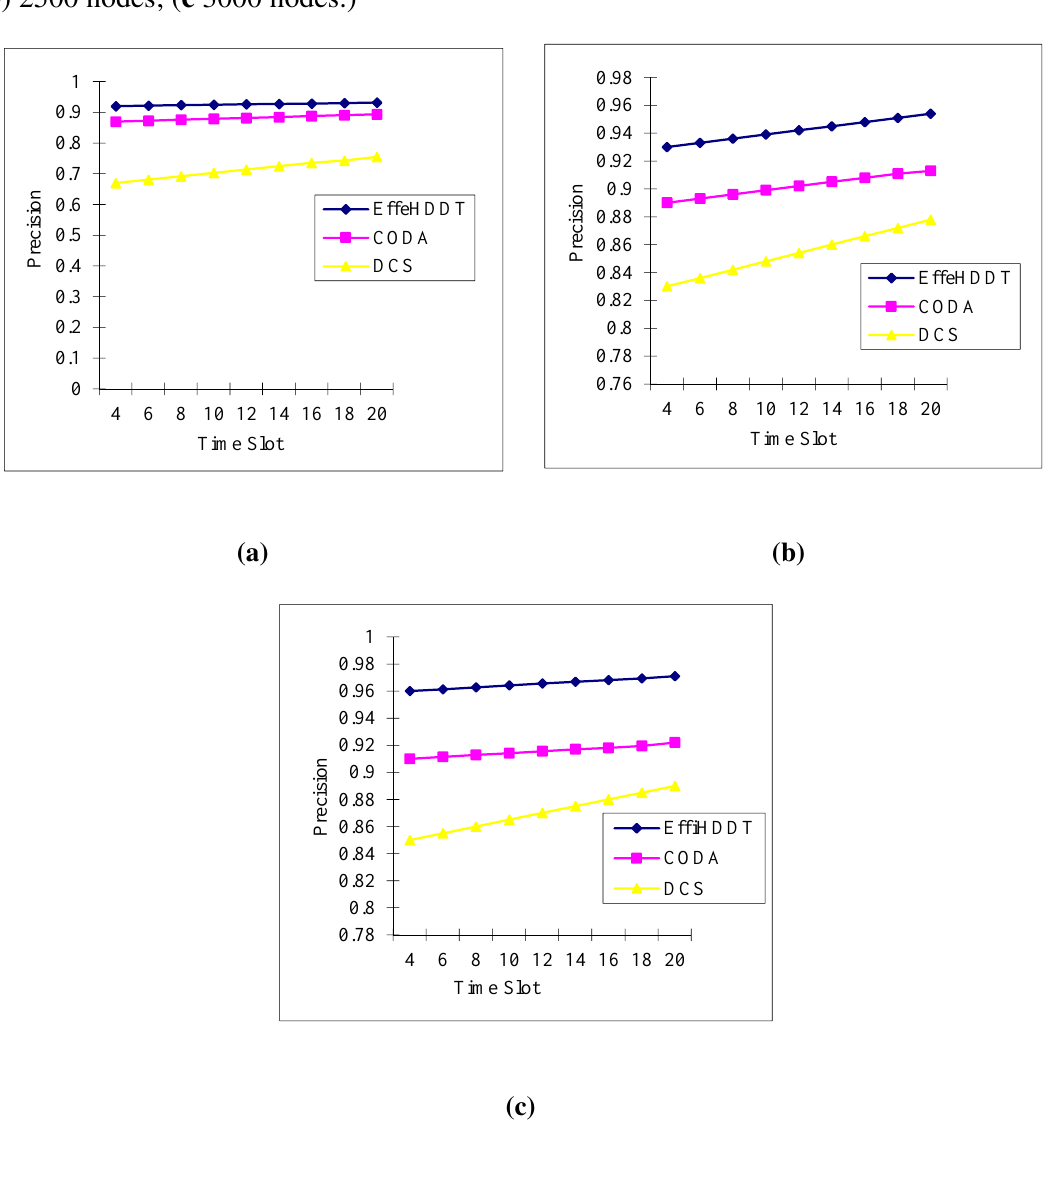
Figure 13. Boundary detection precisions changing with time: ( a ) 2000 nodes; ( b ) 2500 nodes; ( c 3000